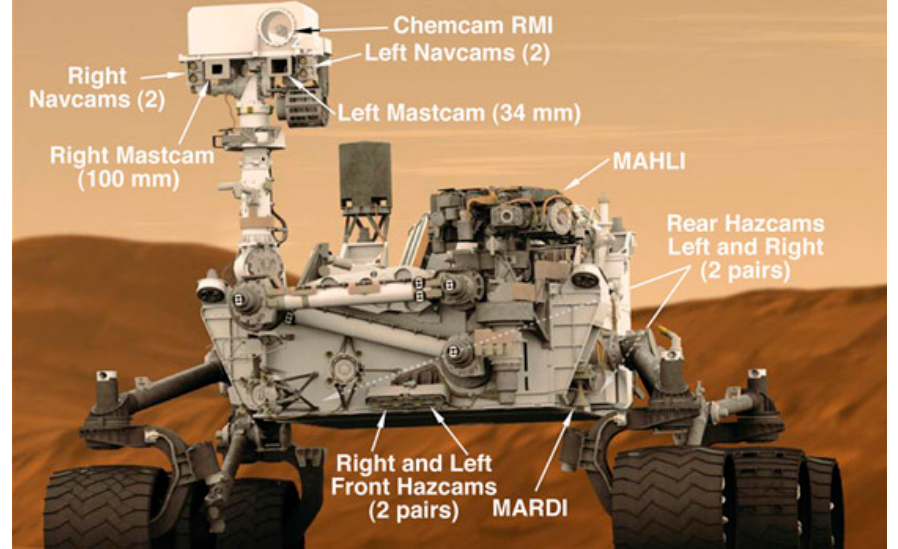
Figure 1. Mars rover Curiosity and its onboard cameras. Mastcam imagers act as eyes of the rover for rock sample selection and rover guidance.